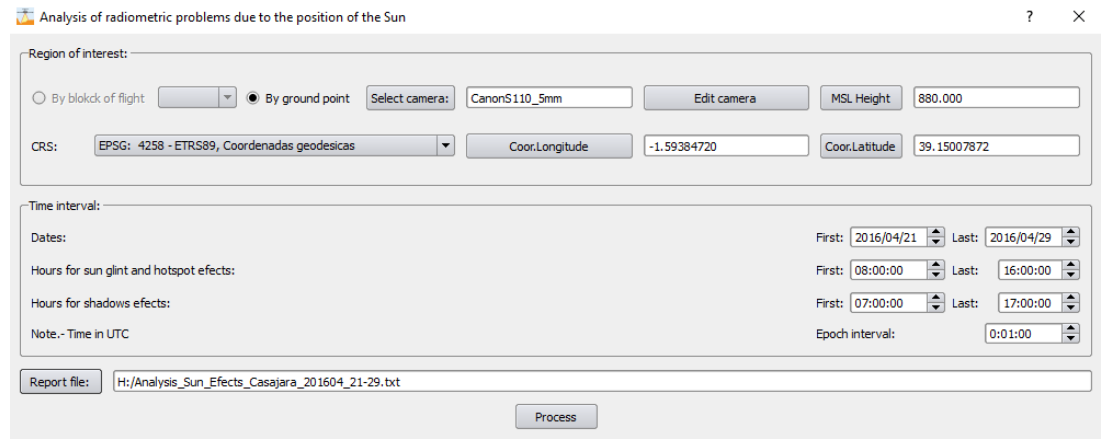
Figure 3. Layout of the developed software, MFliP-v2, for hotspot and sun glint detection in UAV flights.